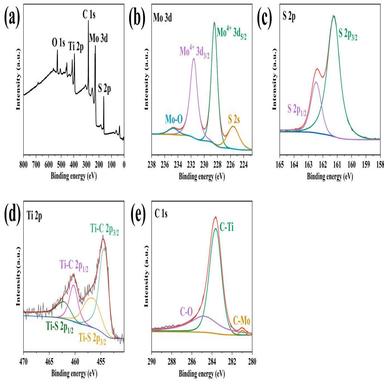
(a) XPS full spectra of MoS2@MXene-20 composites, (b) XPS spectra of Mo 3d, (c) XPS spectra of S 2p, (d) XPS spectra of Ti 2p, (e) XPS spectra of C 1 s.